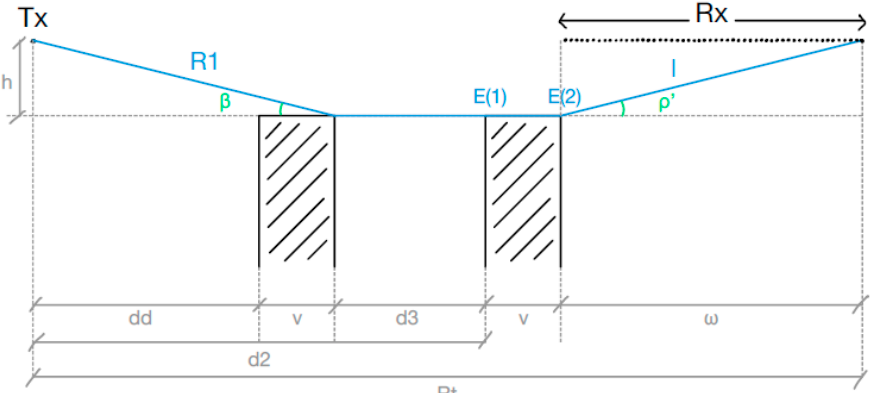
Figure 10. First triple diffraction (Edif_t1) of the considered LOS scenario.